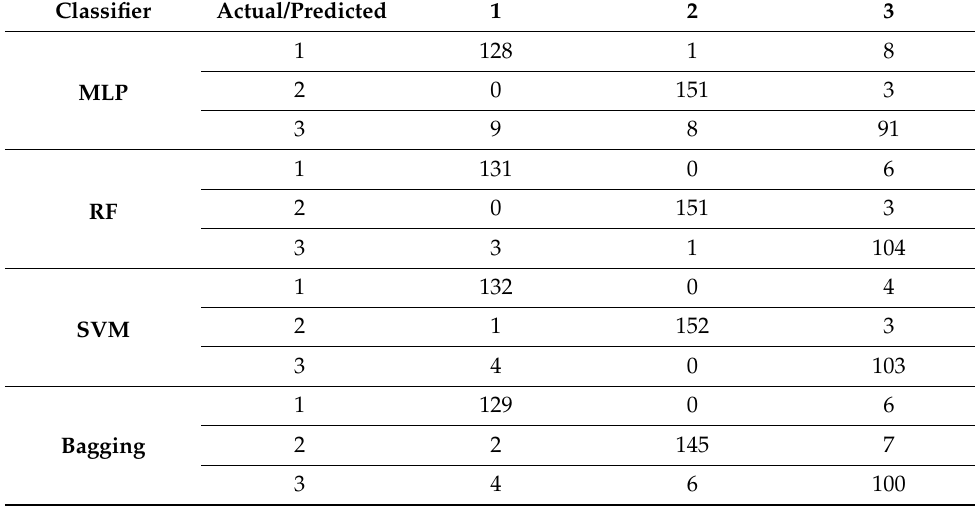
Table 7. Observed frequencies for actual and predicted classification of CTG.